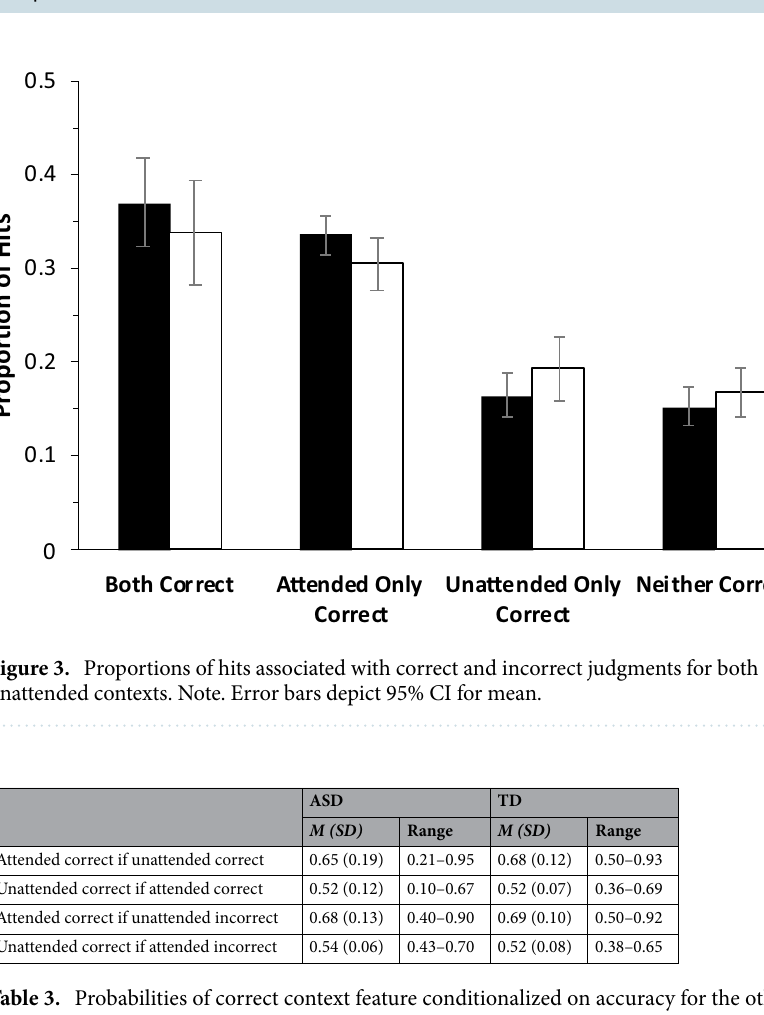
Table 3. Probabilities of correct context feature conditionalized on accuracy for the other context feature.